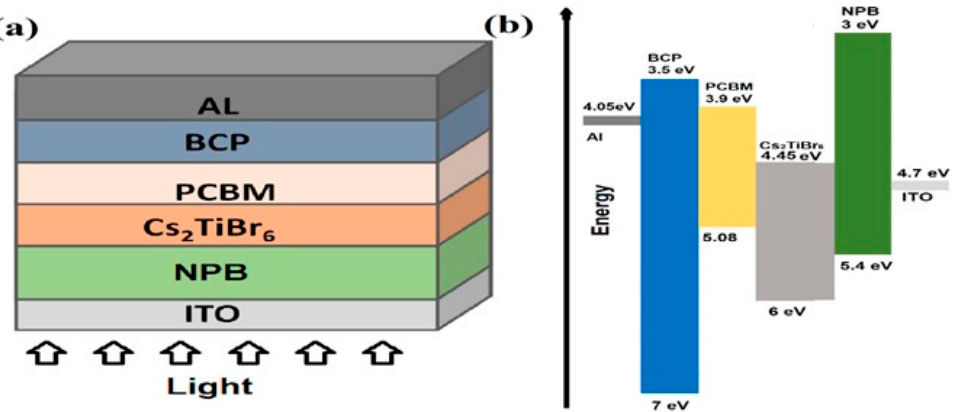
Figure 1. ( a ) The schematic structure, and ( b ) the energy-band alignment diagram of the proposed Ag/BCP/PCBM/Cs 2 TiBr 6 /NPB/ITO solar cell. Ag/BCP/PCBM/Cs 2 TiBr 6 /NPB/ITO solar